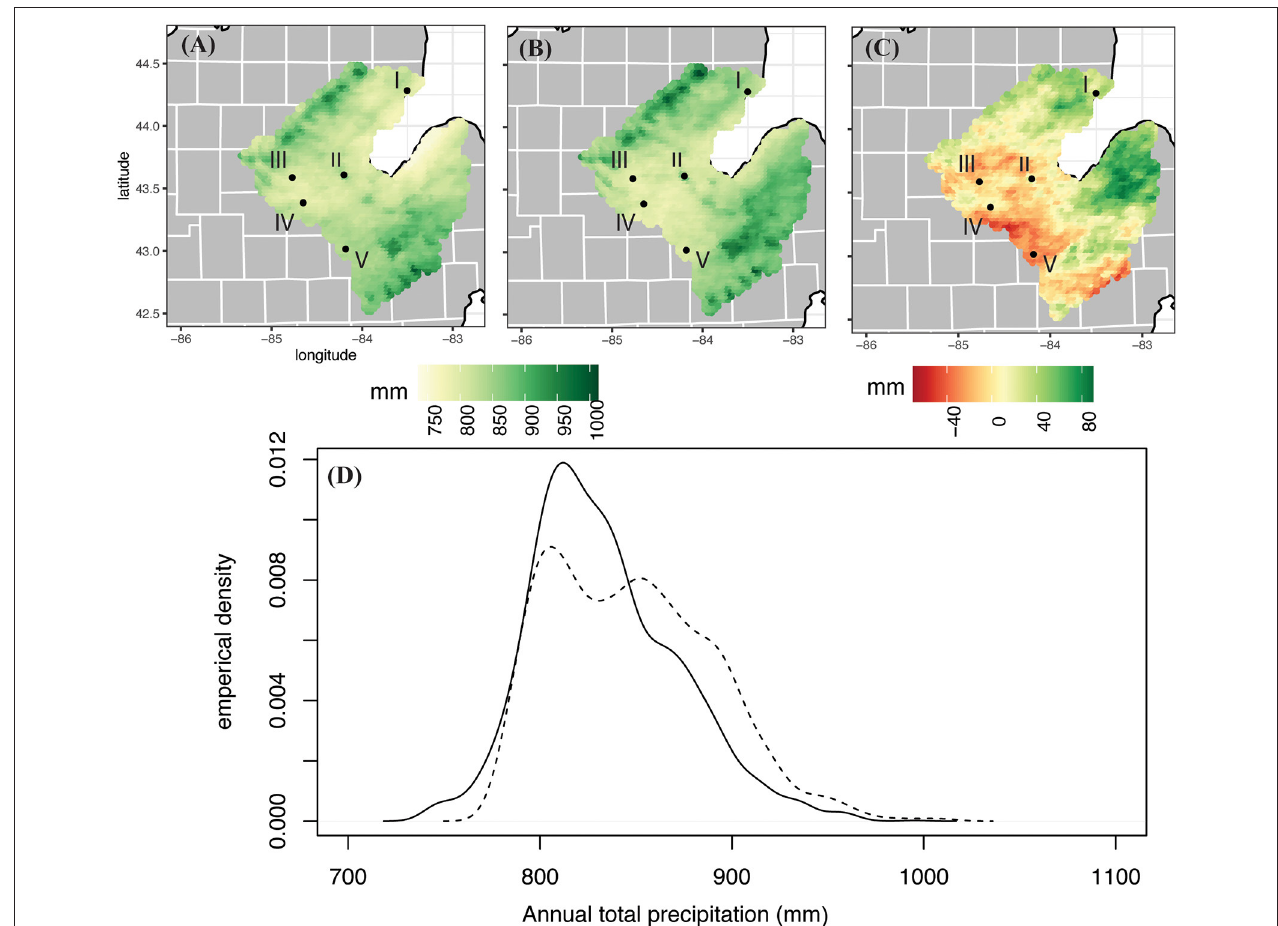
FIGURE 5 | Same as Figure 2 , but for annual total precipitation